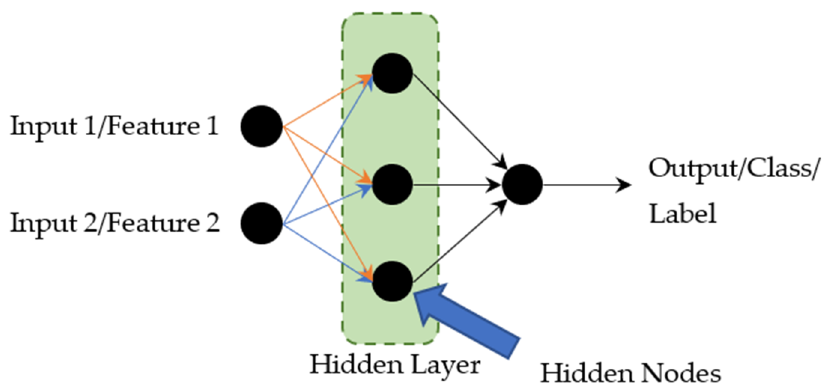
Figure 1. Simple Neural Network.